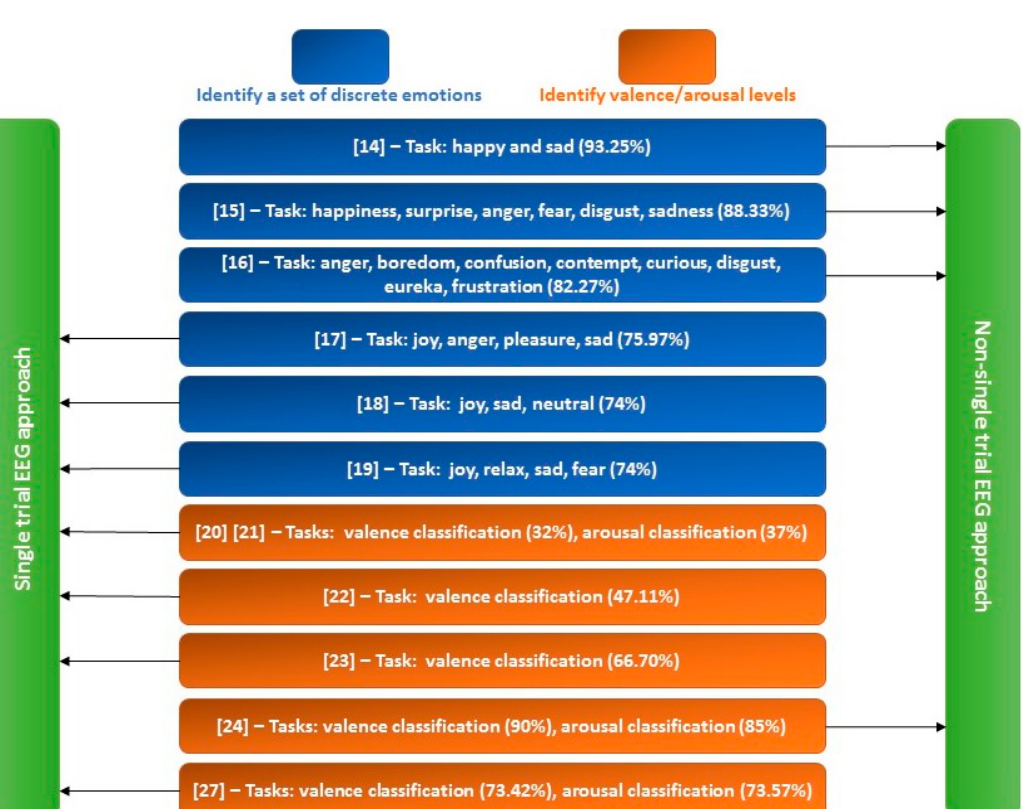
Figure 1. Comparison of related EEG-ER